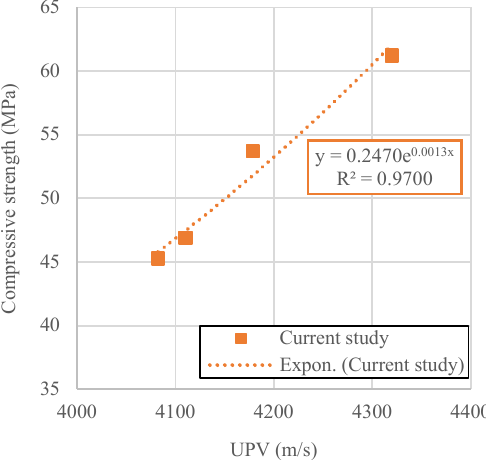
Figure 10. Fitting curve for UPV and the corresponding compressive strength.